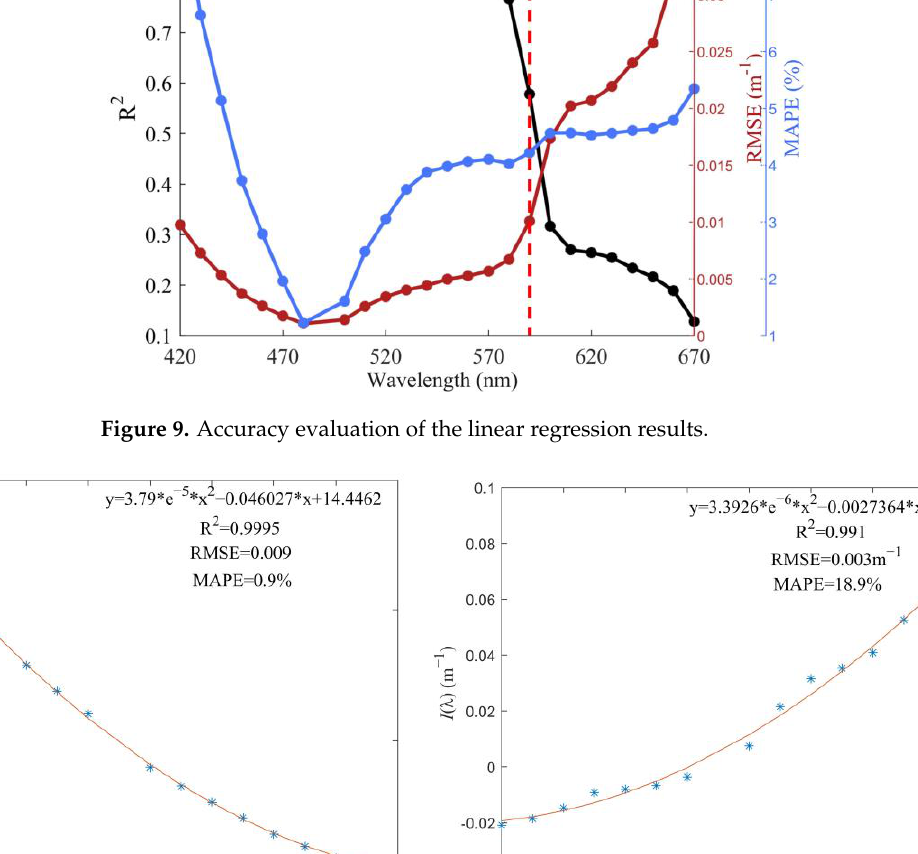
results of ( a ) the slope coefficient 𝑀(𝜆) and ( b ) intercept coefficient 𝐼(𝜆) .